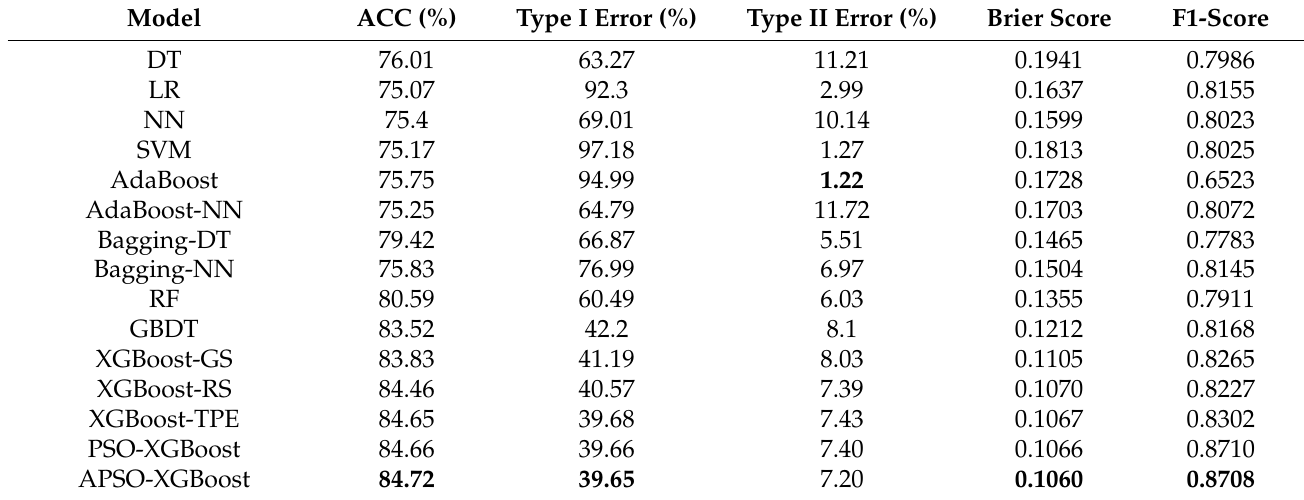
Table 10. Results of the measured performance of models on the P2P-We data